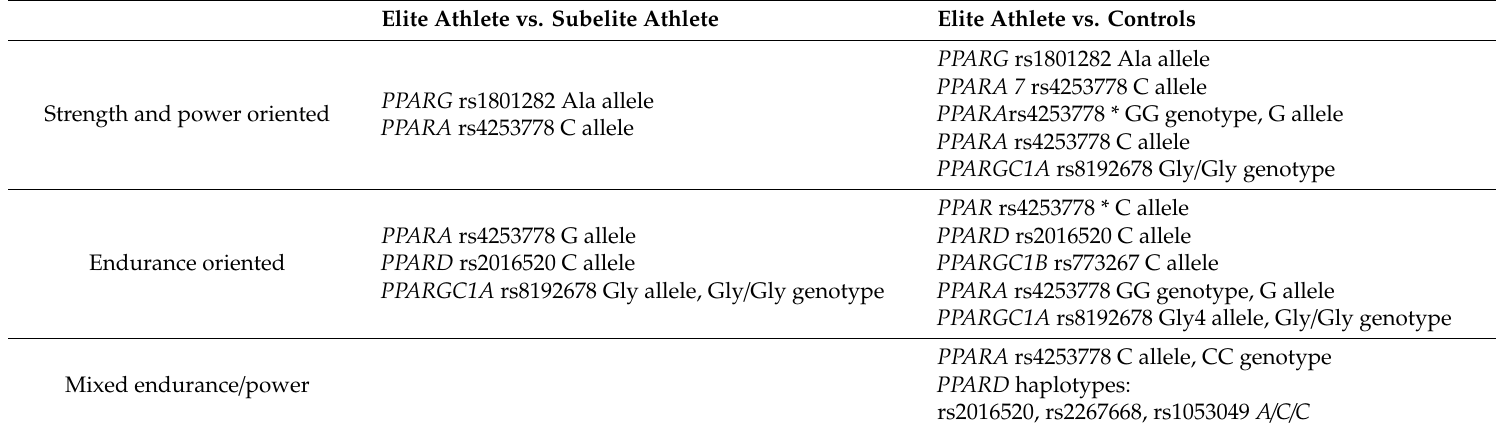
Table 1. Alleles and genotypes related to elite athlete status vs. subelite status in di ff erent types of disciplines and in comparison to controls. * The minority report results specific for the reported population.